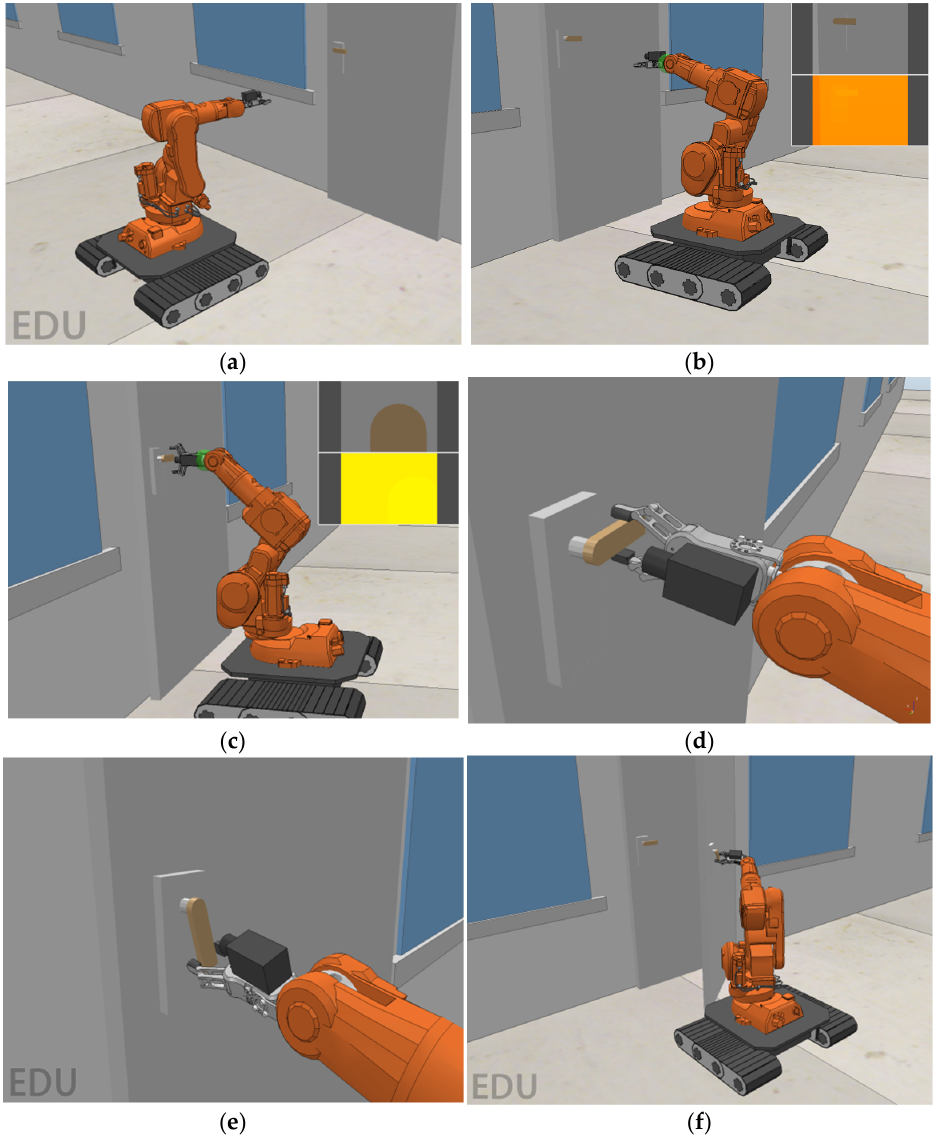
Figure 12. The effect of the simulation experiment. ( a ) The platform moving to the operation area. ( b ) Adjusting the position. ( c ) The platform capture the image. ( d ) The grasping operation. ( e ) Revolving door handle. ( f ) The door-opening operation.